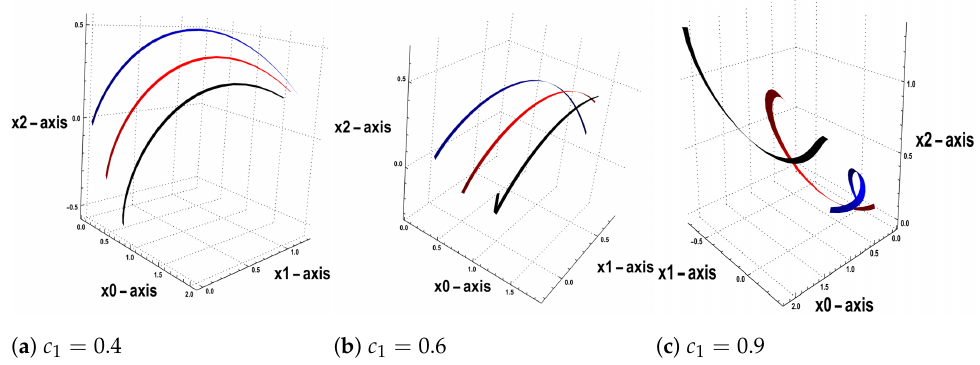
Figure 7. Curves with blue, red, and black colors represent the family of (IFNCC) at t = 0.1,1.4,2.6, respectively, for s ∈ [ 0,2 ] , t ∈ [ 0,3 ] , c 2 = 0.01, µ 0 = 0.3.